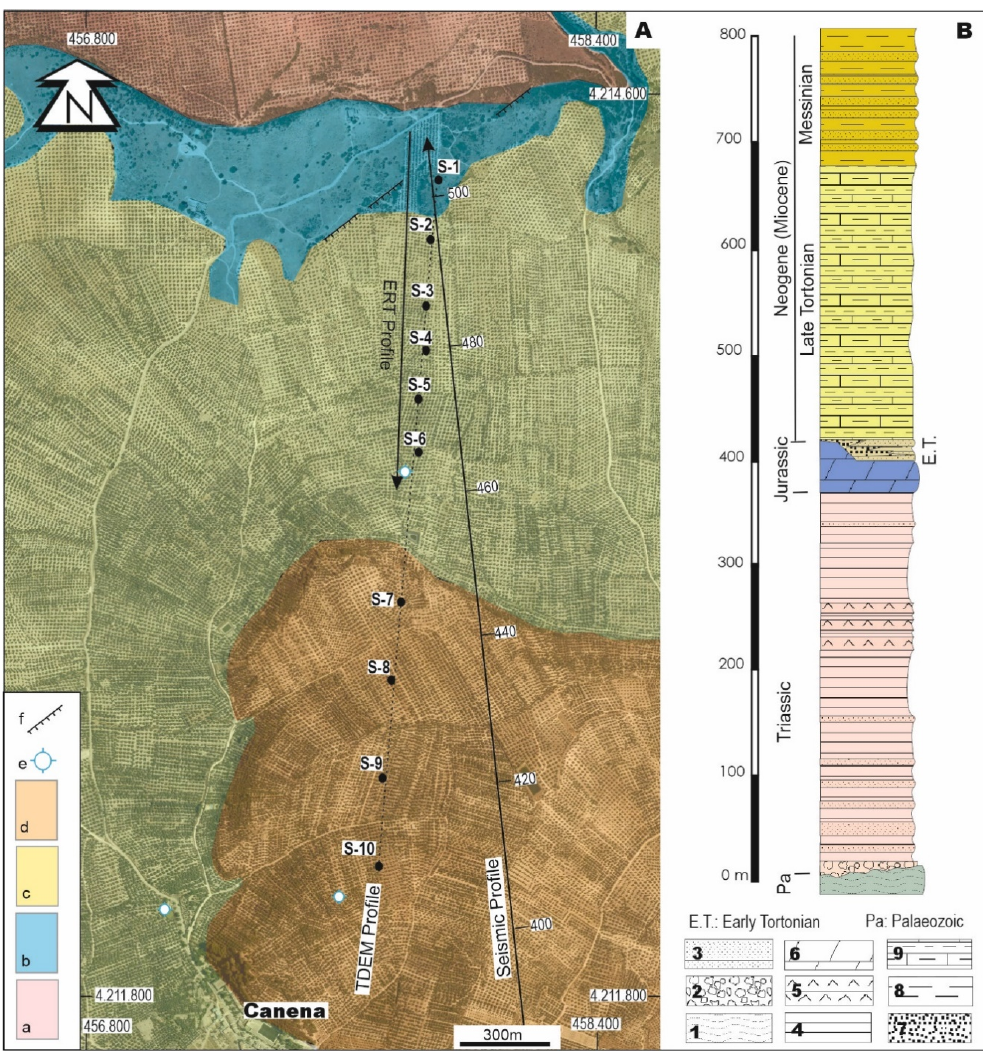
Figure 2. ( A ) Geological mapping of the studied sector. The positions of the electrical resistivity tomography (ERT) line of the seismic reflection profile S84-68 and the time-domain electromagnetic (TDEM) are marked. For this profile, 10 measuring stations (S1 to S10) were set up. Legend: (a) Triassic clays and sandstones (Chiclana de Segura Formation), (b) Jurassic dolomites, (c) Miocene